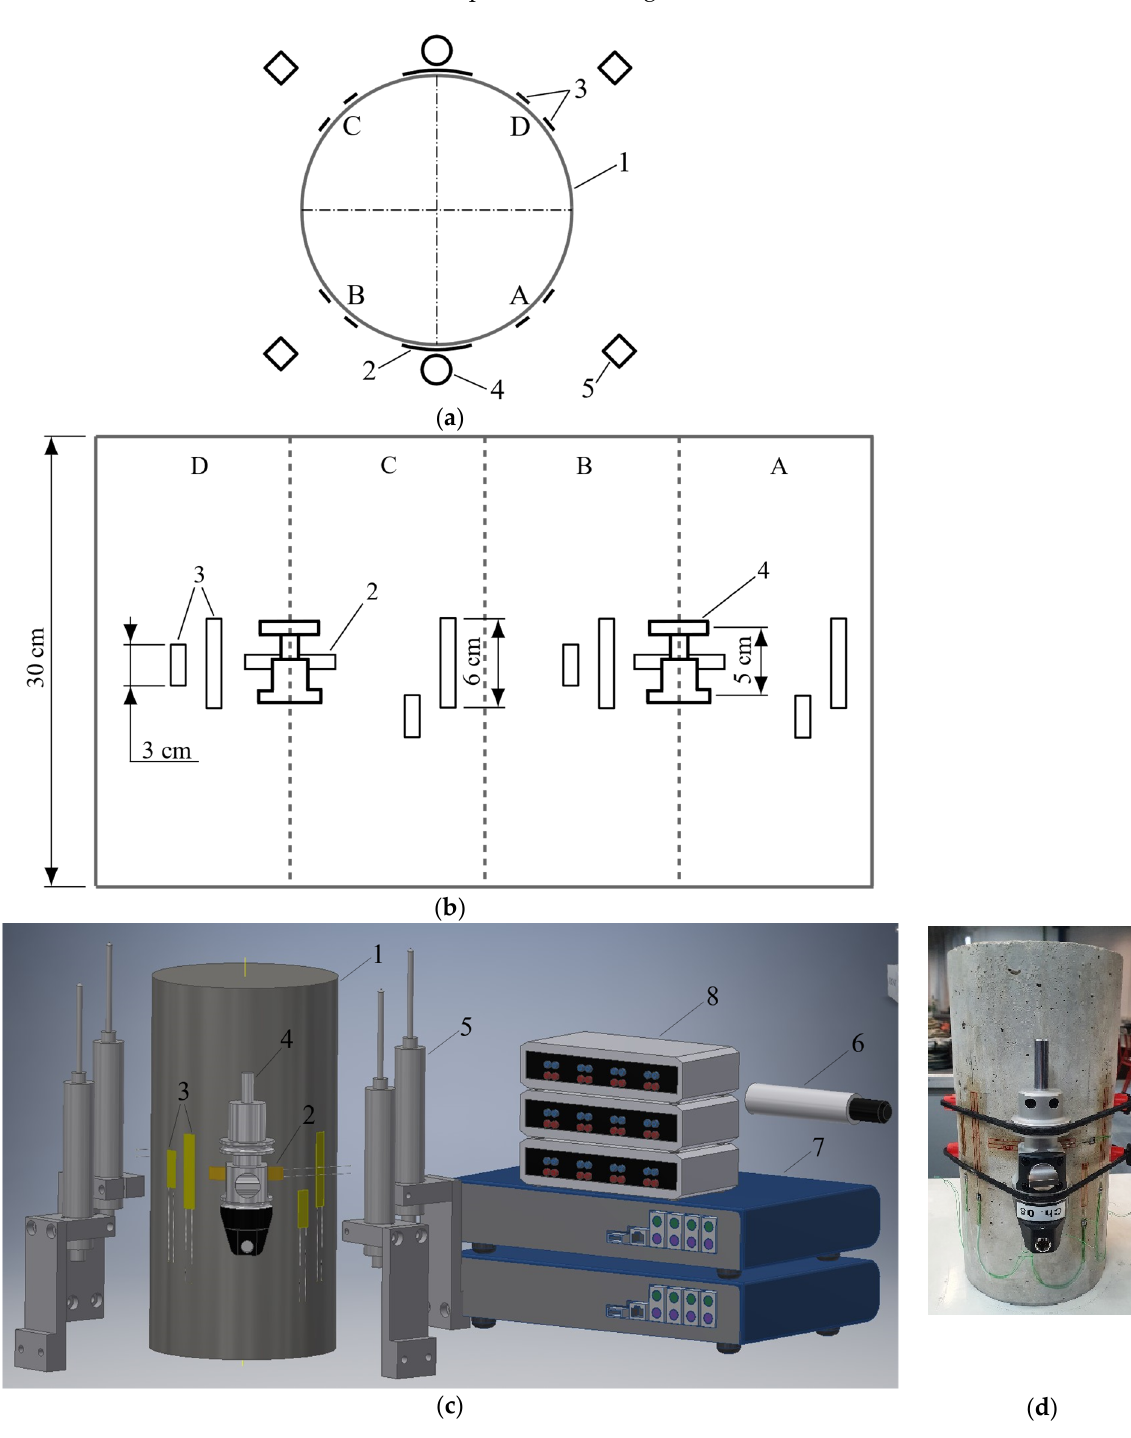
Figure 2. Testing setup: ( a ) Measurement device location scheme; ( b ) Specimen surface development; ( c ) General view; ( d ) Specimen before loading. 1. Cylindrical concrete specimen; 2. Transverse SG sensors; 3. Longitudinal SG sensors; 4. HAT devices; 5. LDT devices; 6. Load sensor; 7. Data logger; 8. Wheatstone bridge; A, B, C, and D sectors (according to Figure 2a). The upper surface of the cylindrical specimens was leveled by a thin layer of sifted fine-grain sand to obtain an additional effect of reducing the friction between the testing machine plate and a specimen.